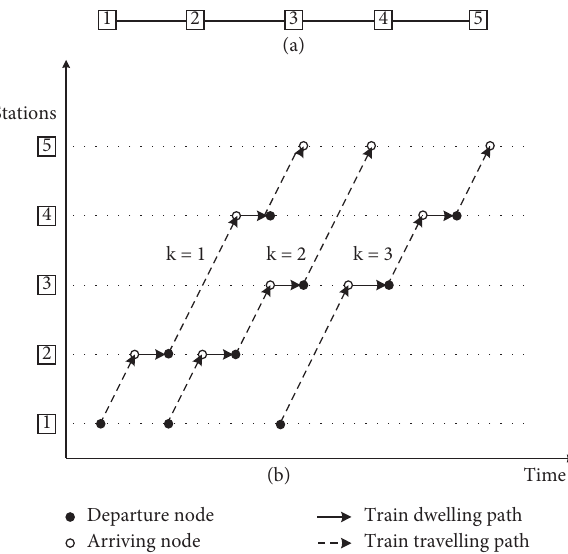
Figure 3: A simple high-speed rail corridor and its graphical train timetable.